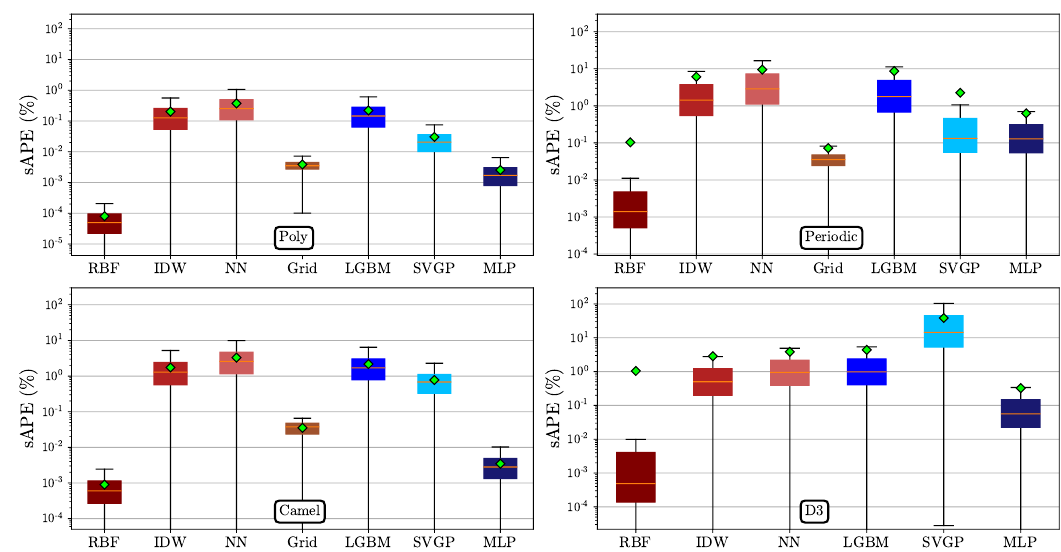
Figure 5: Boxplots of the symmetric absolute percent error (%) for four test func- tions in 3 dimensions. Red colors indicate interpolation while blue colors indicate regression methods.